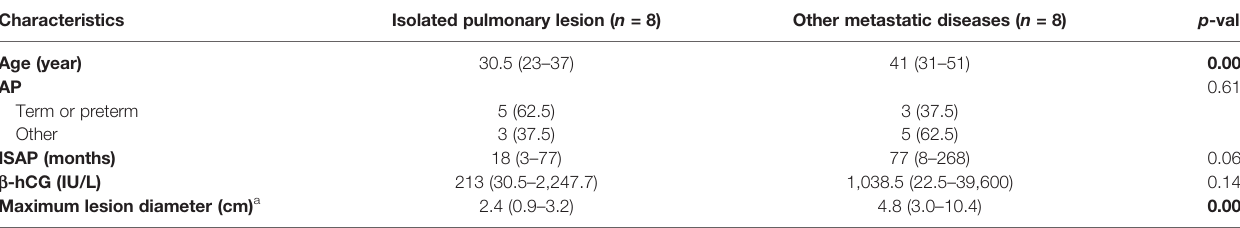
TABLE 3 | Comparison of the clinical data between the two groups of patients with metastatic diseases.